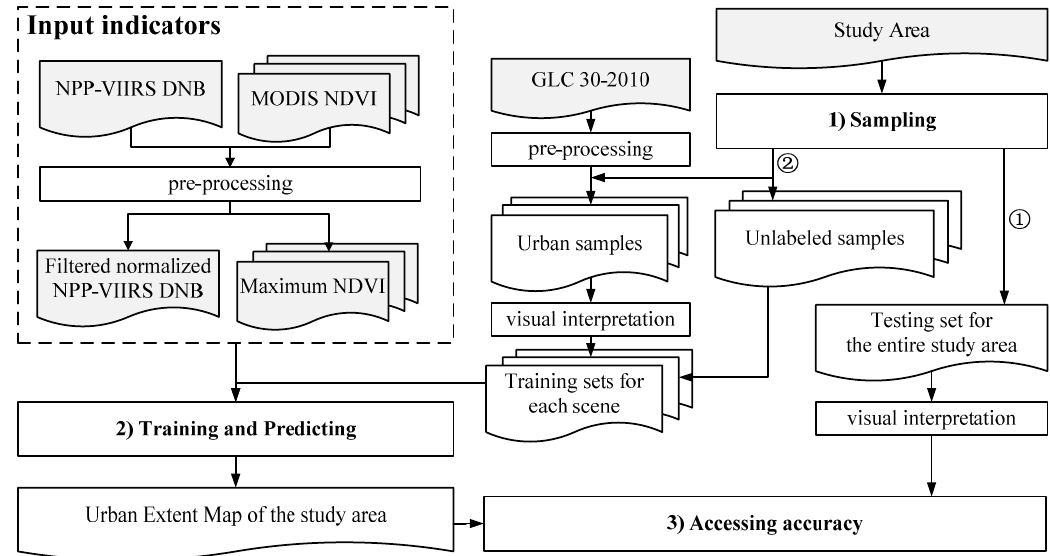
Figure 3. Flowchart of extracting urban extent in the study area.